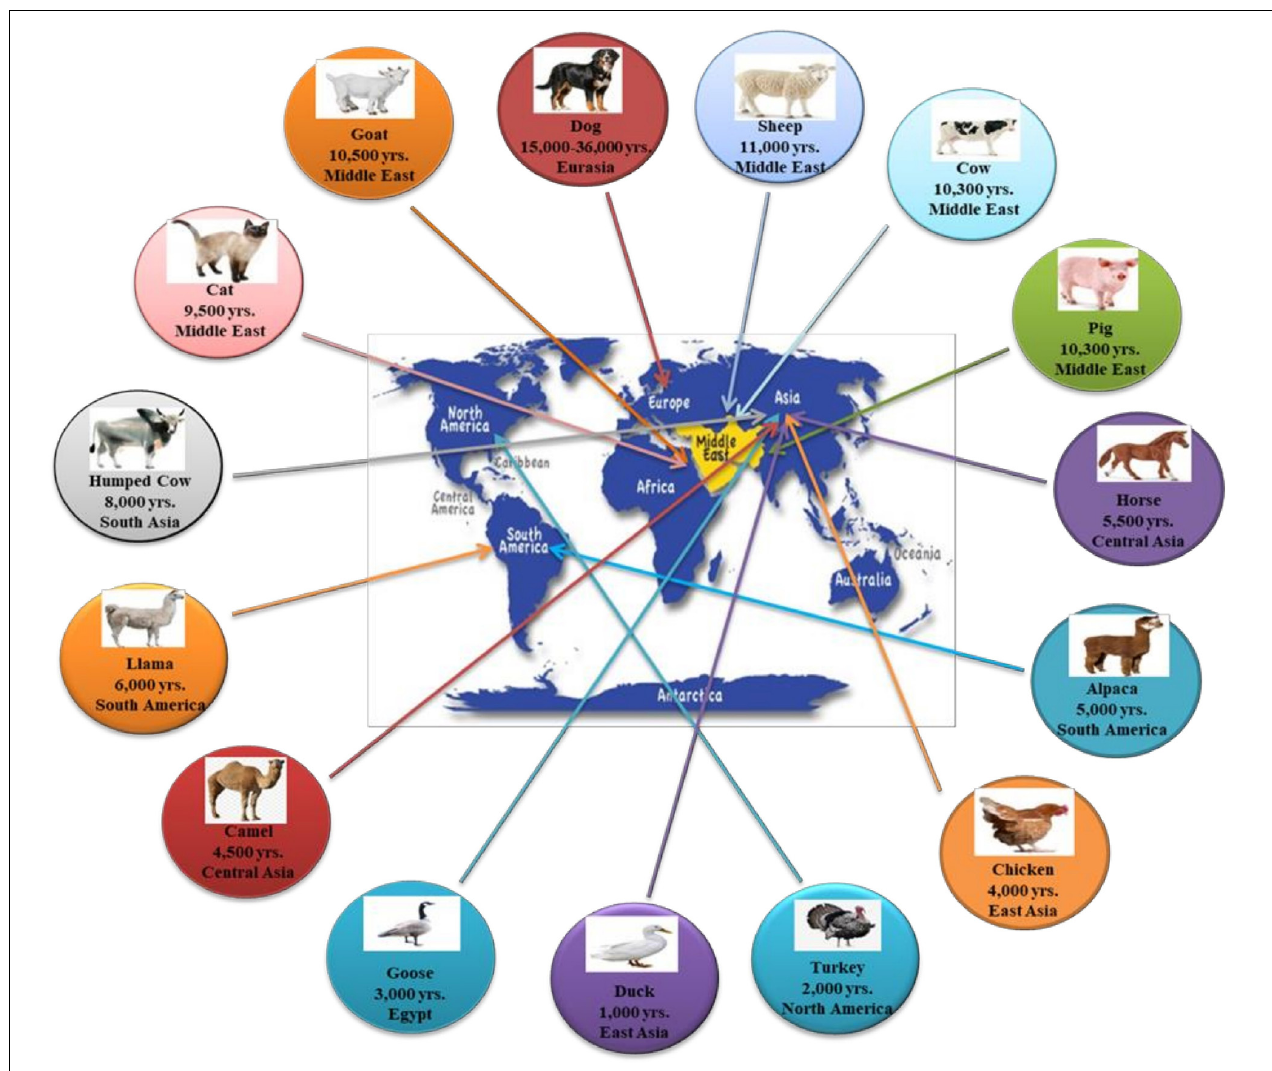
FIGURE 1 | The timeline of animal domestication (adapted from Zeder,